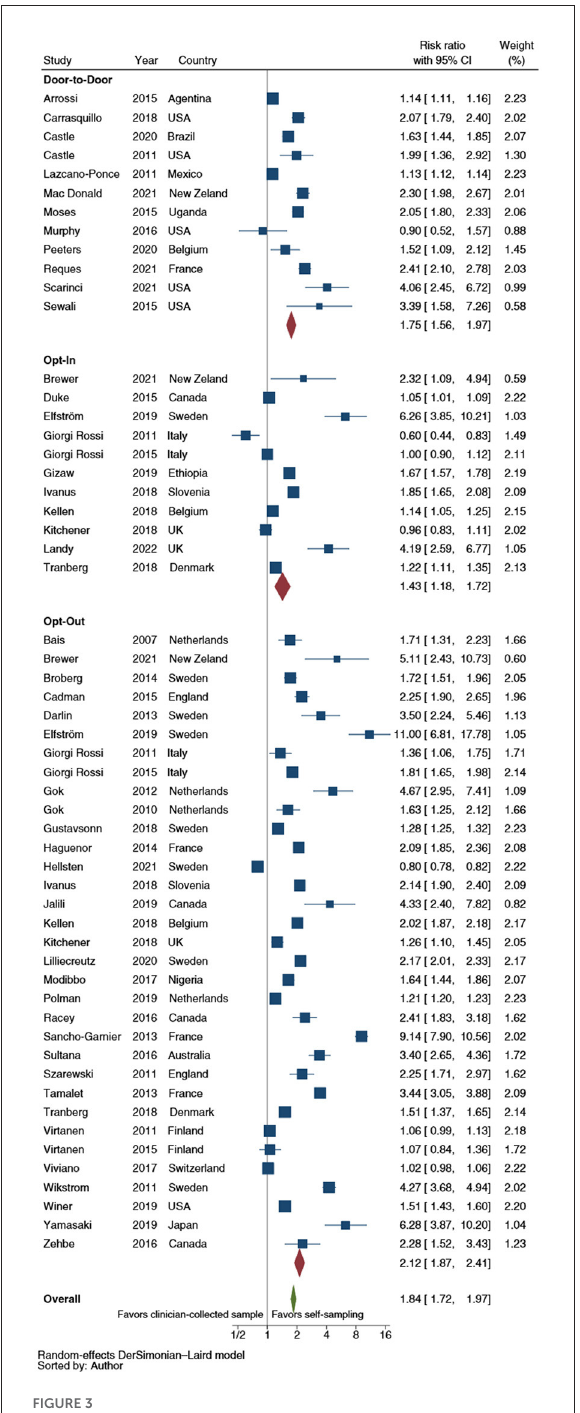
FIGURE3 Forest plot comparing cervical cancer screening (CCS) uptake for HPV testing by strategy of self-samplers’ distribution vs. clinician-collected samples. Homogeneity ( I -squared): 98.8%; Cochrane’s Q test for between-group differences: Q = 4,426.36; df = 2; p =